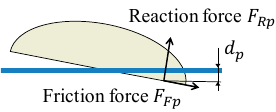
Figure 4. Linear spring